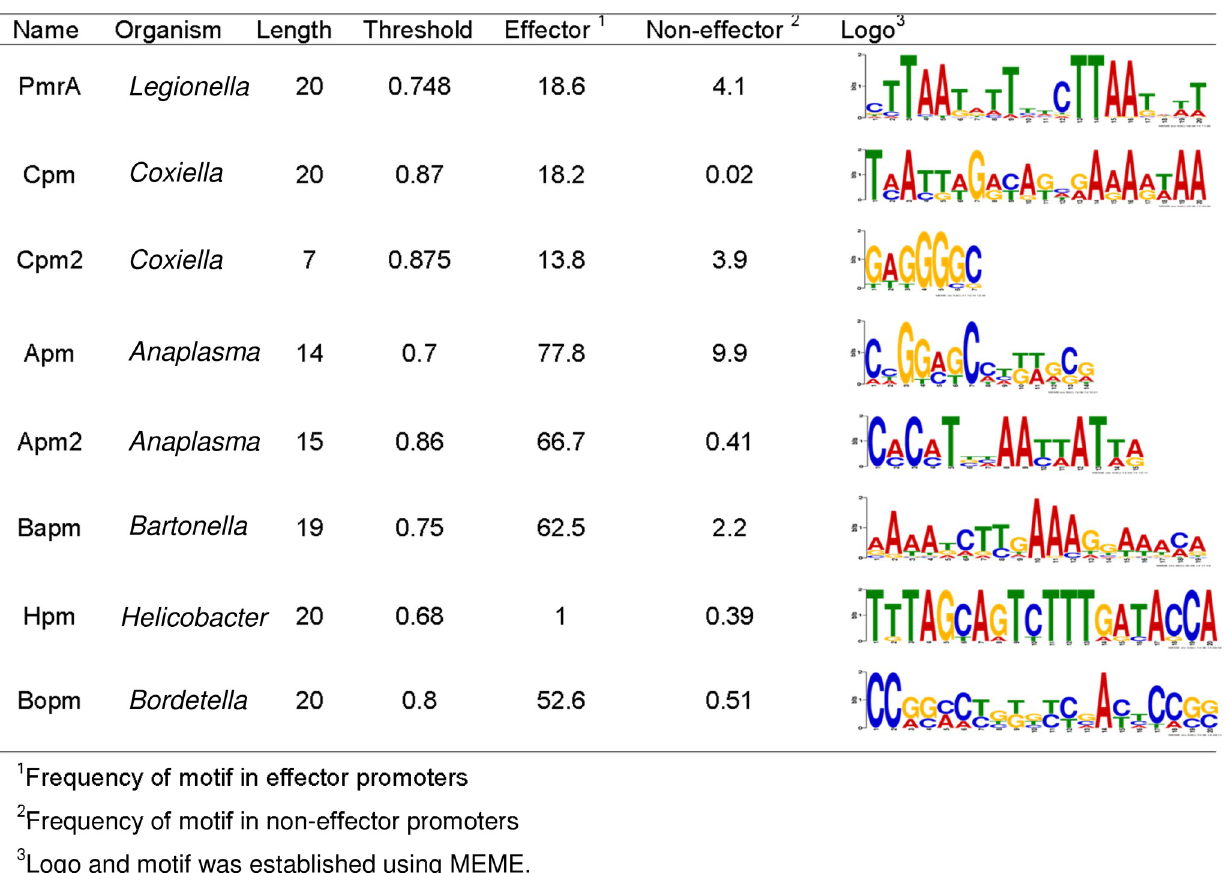
Fig 1. Enriched DNA motifs found in several bacteria in the intergenic region upstream of known type IV effectors and implemented in S4TE 2.0 searches.